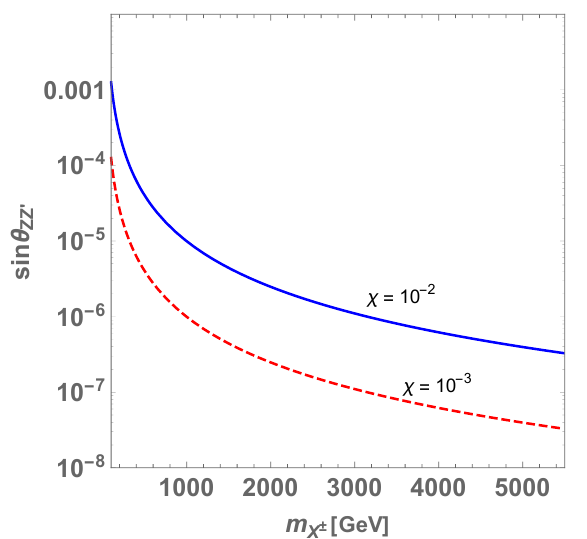
for χ = 10 − 2 and 10 − 3 where we fix 2 v 2 X ±